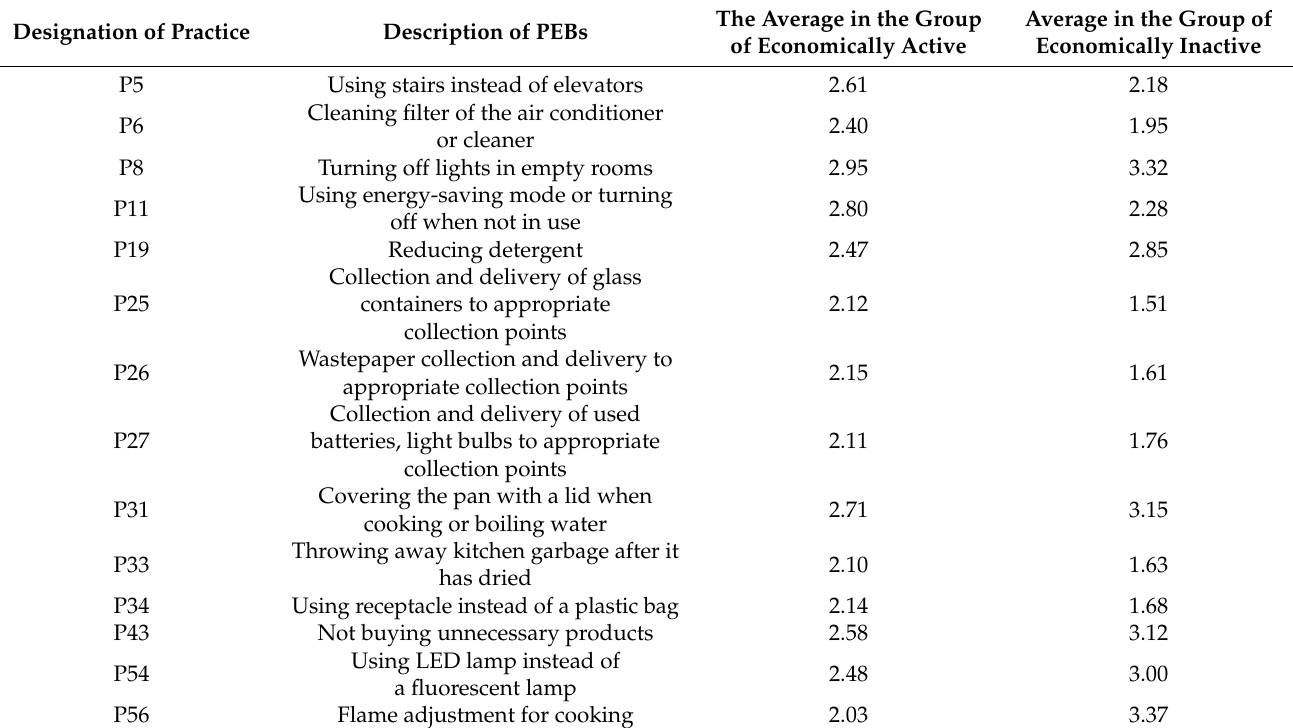
Table 5. Statistically significant (at the p < 0.05 level) results of the Mann–Whitney test with a grouping variable—economic